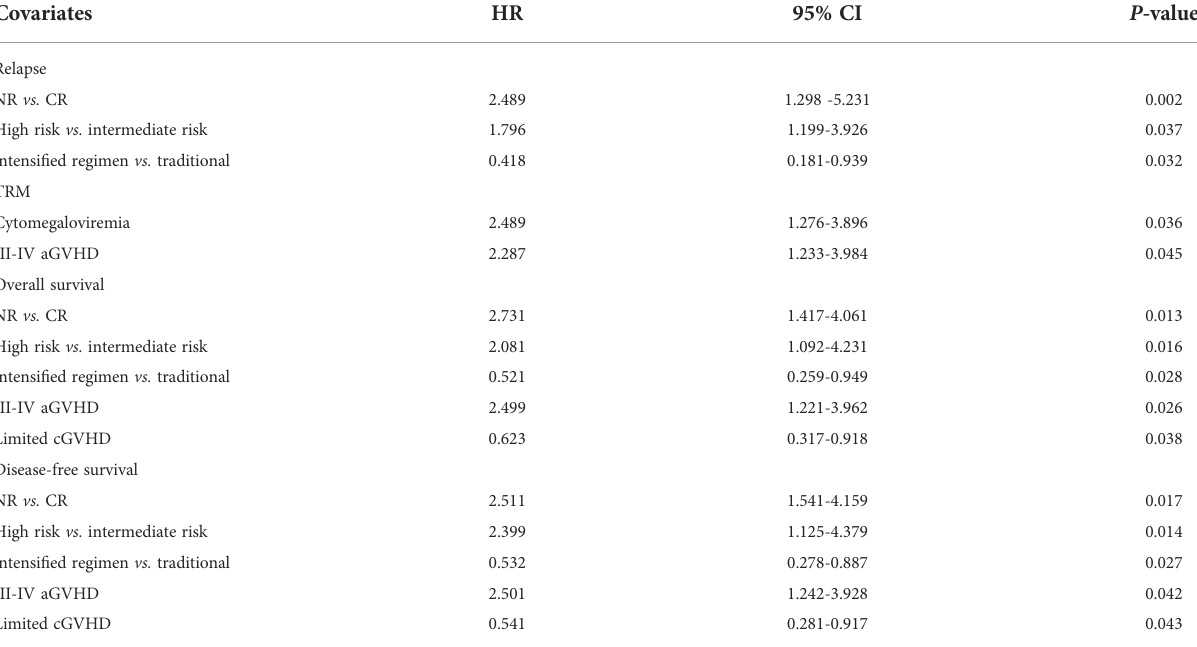
TABLE 3 Multivariate analysis of factors associated with outcomes of patients with hematological malignancies undergoing ATG-based haploidentical stem cell transplantation. Covariates HR 95% CI P